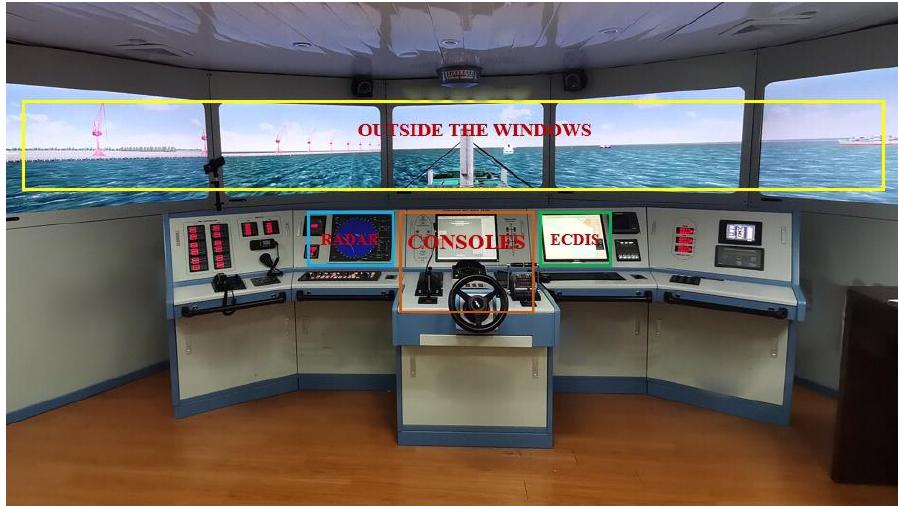
Figure 4. The experimental situation in ship pilotage.